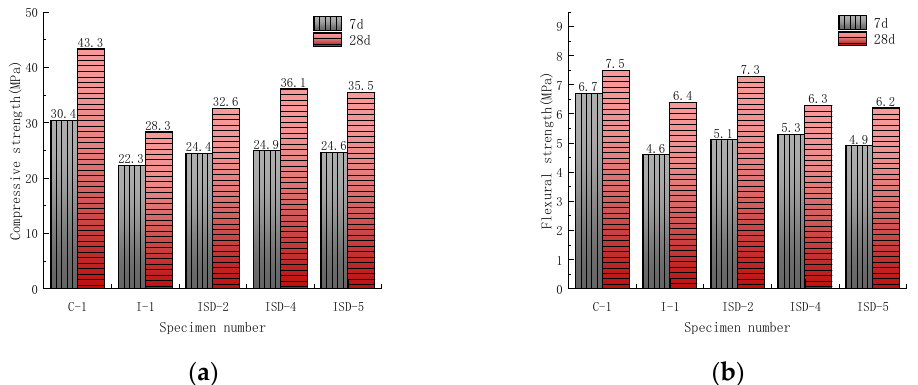
Figure 3. Effect of iron tailings doping ratio on ( a ) compressive strength and ( b ) flexural strength of the ISD admixture.